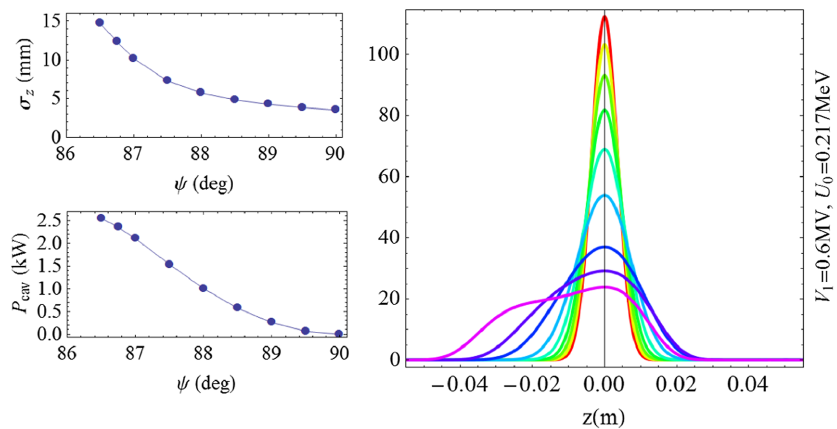
FIG. 2. Equilibrium bunch profiles in the presence of two ALS HHCs in ALS-U for various tuning (right), the corresponding rms bunch length (top left), and power dissipated by each cavity (bottom